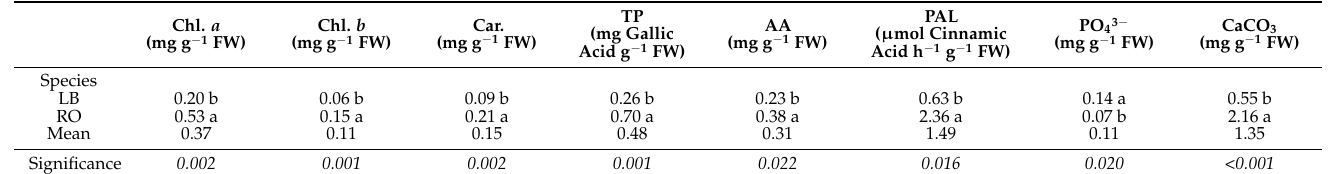
Table 2. The phytochemical composition of “Lollo Bionda” lettuce and cultivated rocket at harvest (d0).